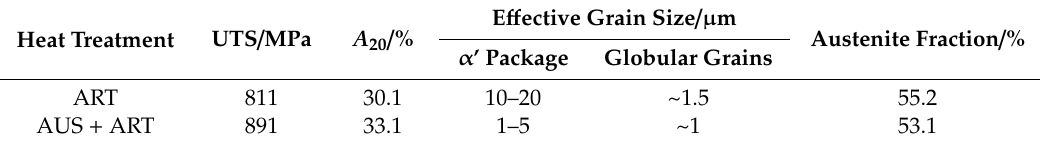
Table 2. Summary of microstructural features and mechanical properties ( A 20 : total